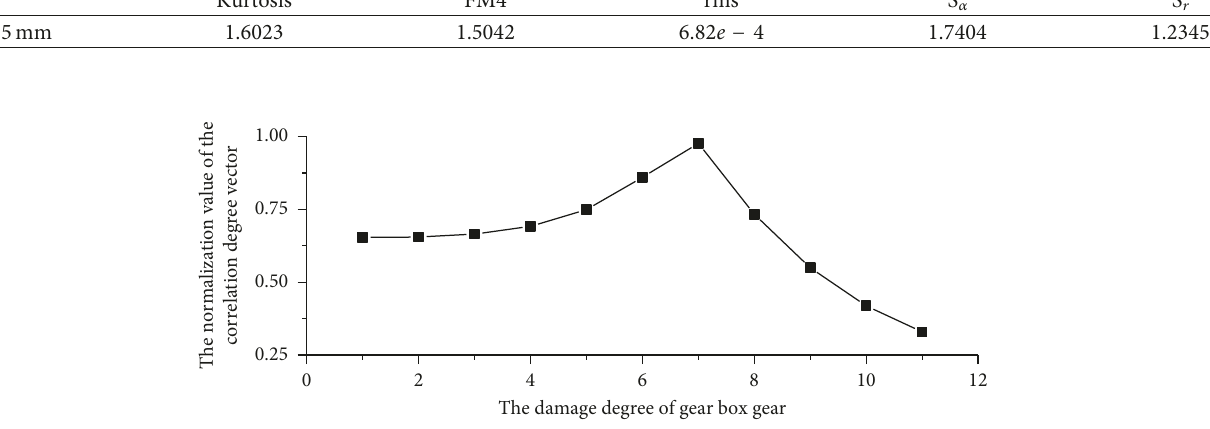
Figure 15: Normalization curve of the correlation degree